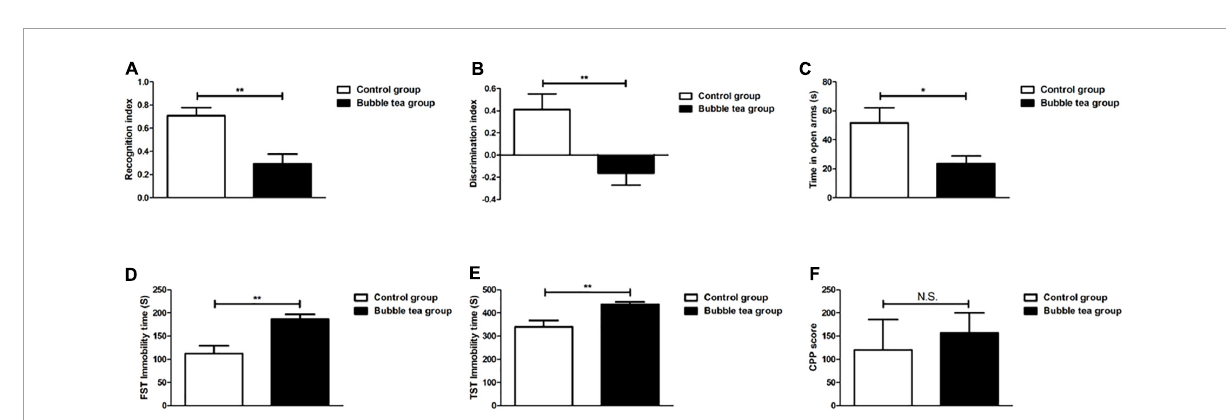
FIGURE2 Effect of bubble tea administration on body weight. * P < 0.05.